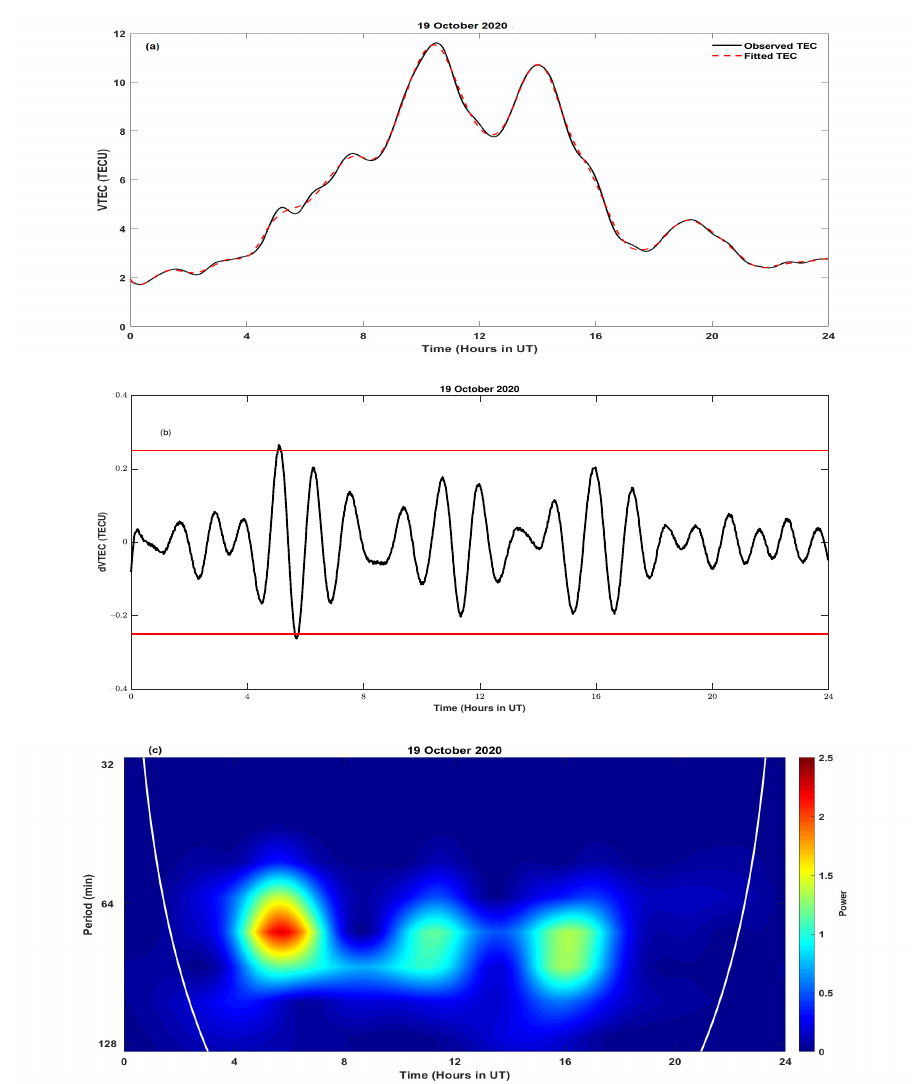
Figure 12. Same ( a – c ) as Figure 9, but for IZMI